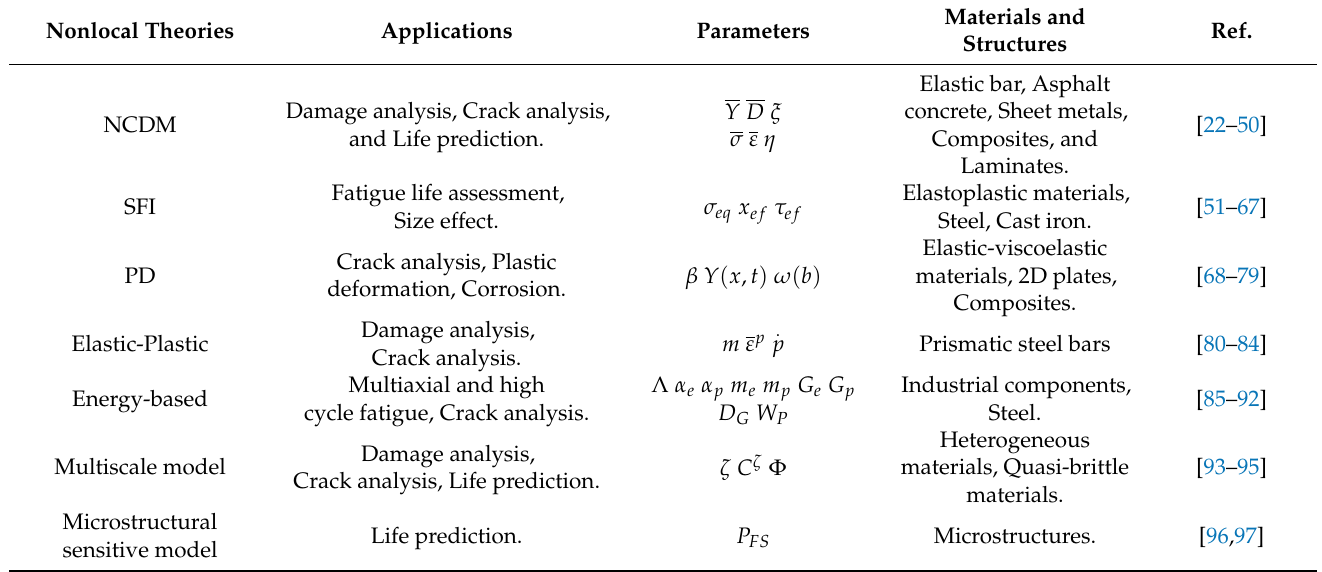
Table 2. Nonlocal theories in fatigue assessment of